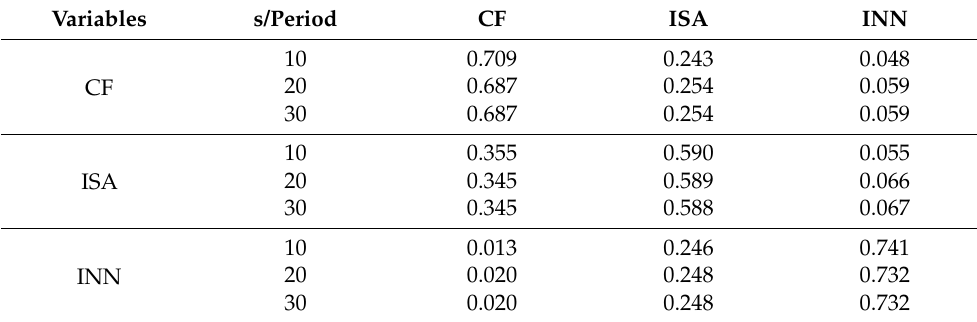
Table source: authors’ own